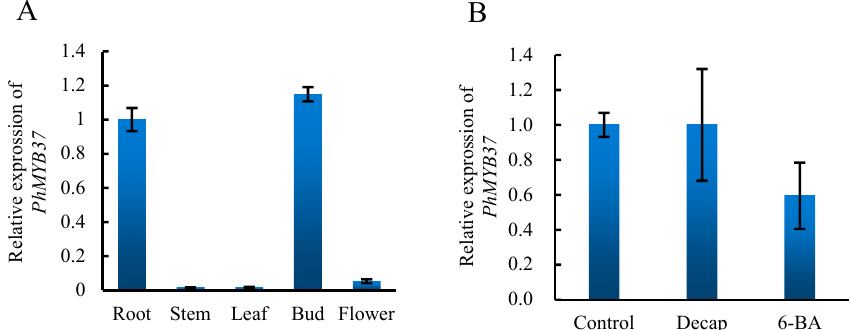
Figure 4. Expression analysis of PhMYB37 . ( A ) The expression analysis of PhMYB37 in different tissues. ( B ) The expression analysis of PhMYB37 under different treatments. Three pools of 20 plantlets served as the source of all samples. Decap represents decapitation.